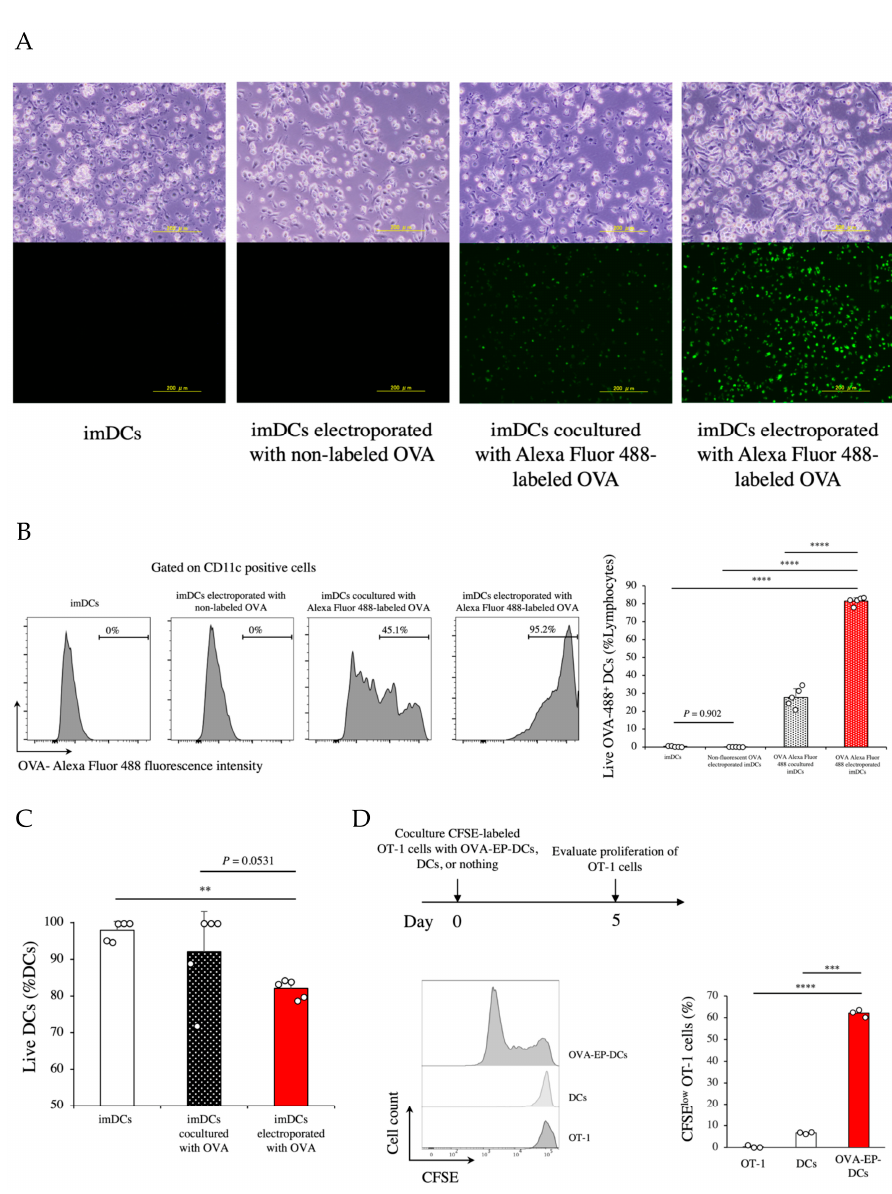
Figure 1. Dendritic cells loaded with ovalbumin protein by electroporation (OVA-EP-DCs) effectively stimulated OT-1 CD8 + T cells. Immature dendritic cells (imDCs) derived from murine bone marrow were electroporated with full-length ovalbumin (OVA) protein using the program of MaxCyte System. ( A ) The photomicrographs show control imDCs, imDCs electroporated with non-labeled OVA, imDCs cocultured with Alexa Fluor 488 labeled OVA, or imDCs electroporated with Alexa Fluor 488 labeled OVA. ( B ) Histograms represent the frequency of OVA loading into the imDC. The Alexa Fluor 488 fluorescence intensity was measured by flow cytometry in imDCs, imDCs electroporated with non- labeled OVA, imDCs cocultured with Alexa Fluor 488 labeled OVA, or imDCs electroporated with Alexa Fluor 488 labeled OVA. The graph shows the quantification of the frequency of OVA loading into the imDCs in each group ( n = 5). ( C ) The viability of imDCs electroporated with OVA was compared with imDCs cocultured with OVA and control imDCs ( n = 5). ( D ) Proliferation rates of OT-1 CD8 + T cells cultured alone, or cocultured with DCs, or with OVA-EP-DCs were investigated in vitro. The CFSE-labeled OT-1 CD8 + T cells (5 × 10 5 ) were cultured for 5 days in each group. CFSE fluorescence intensity of OT-1 CD8 + T cells was measured by flow cytometry. The representative histograms of CFSE intensity and the proportion of CFSE low OT-1 cells are shown ( n = 3). To analyze statistical differences among multiple groups, ANOVA with Holm’s post hoc test was performed. ** p <0.01, *** p < 0.001, and **** p <